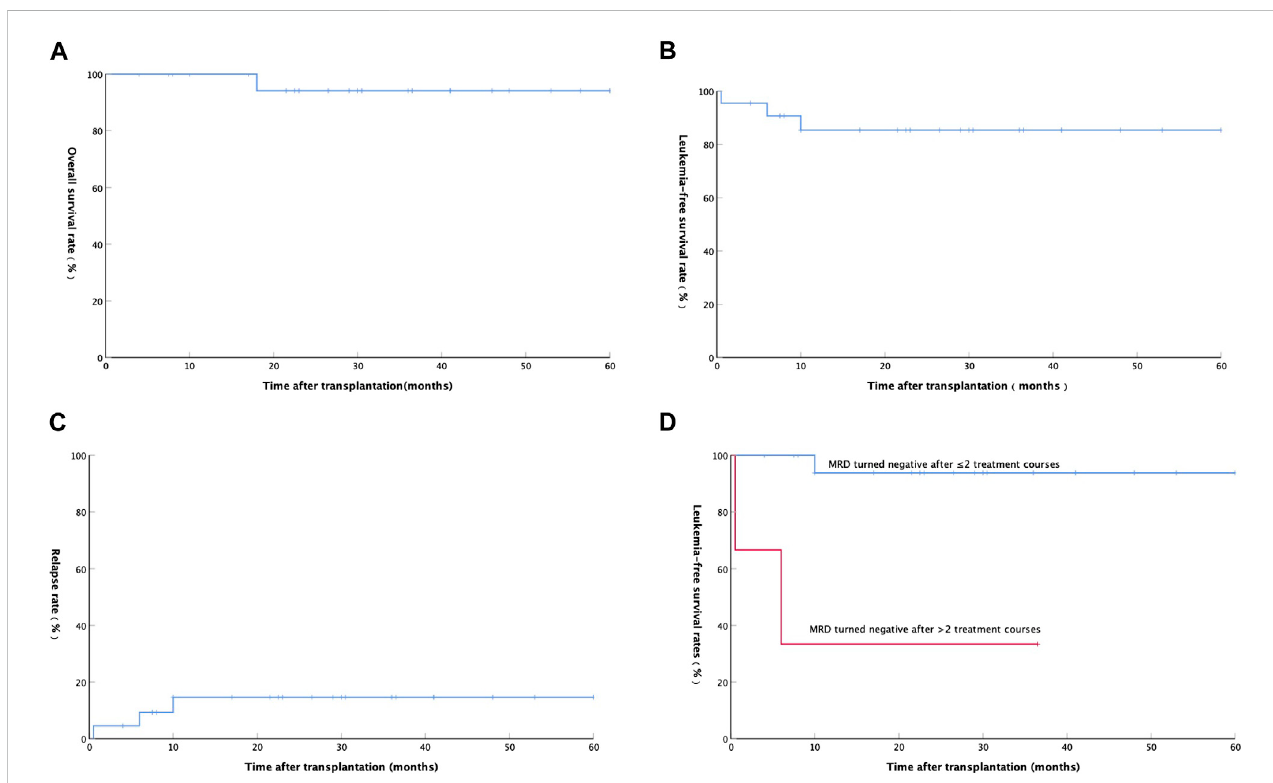
FIGURE 1 (A) Overall survival rate of 22 AML patients after auto-HSCT; (B) Leukemia-free survival rate of 22 AML patients after auto-HSCT; (C) Relapse rate of 22 AML patients after auto-HSCT; (D) Relationship between Leukemia-free survival rate and minimal residual disease in 20 patients with AML(except